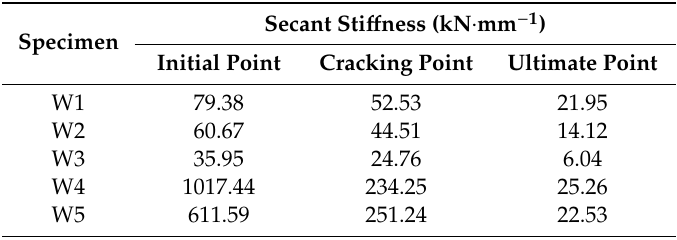
Table 6. Secant sti ff ness of all the specimens at characteristic points. Table 6. Secant stiffness of all the specimens at characteristic points.